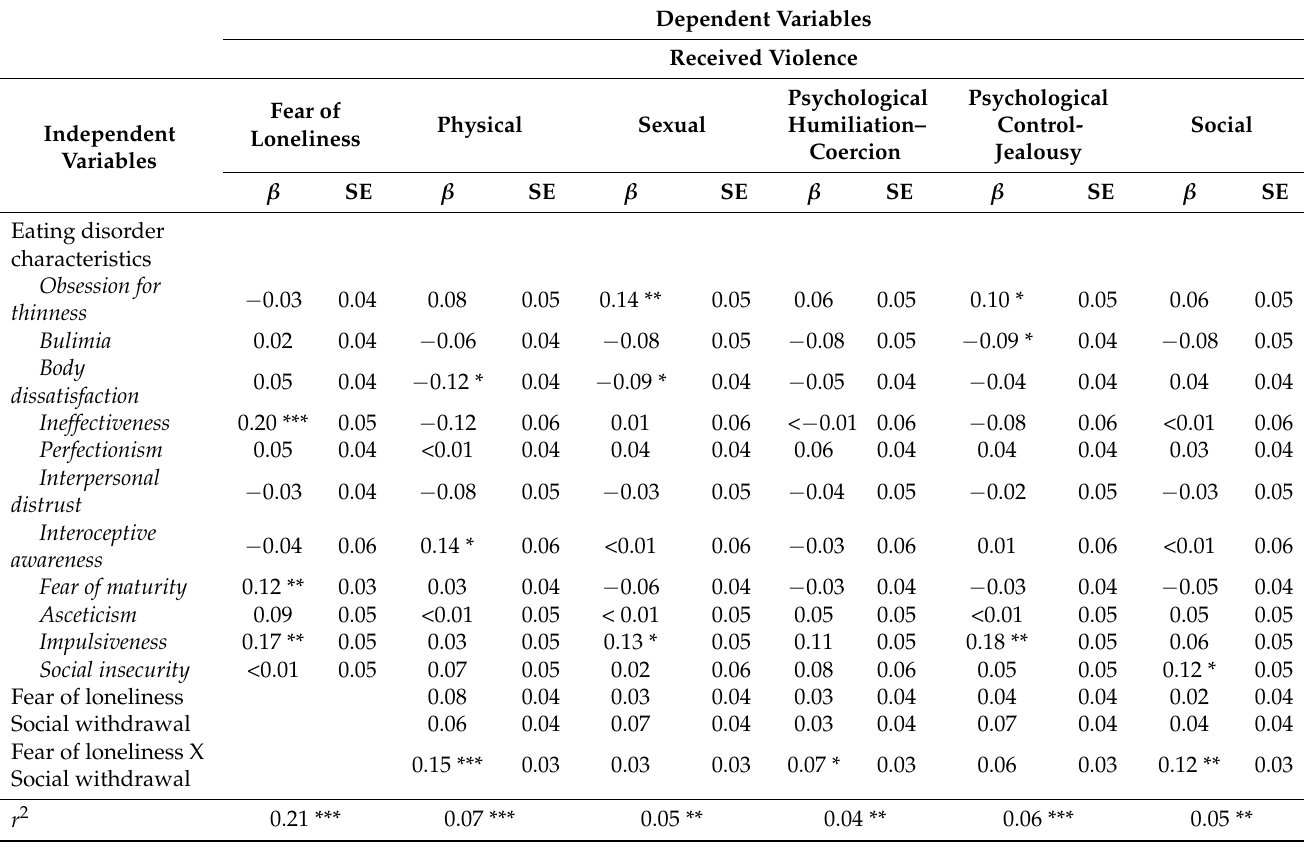
Table 3. Standardised direct and interaction effects of the model based on path analysis.